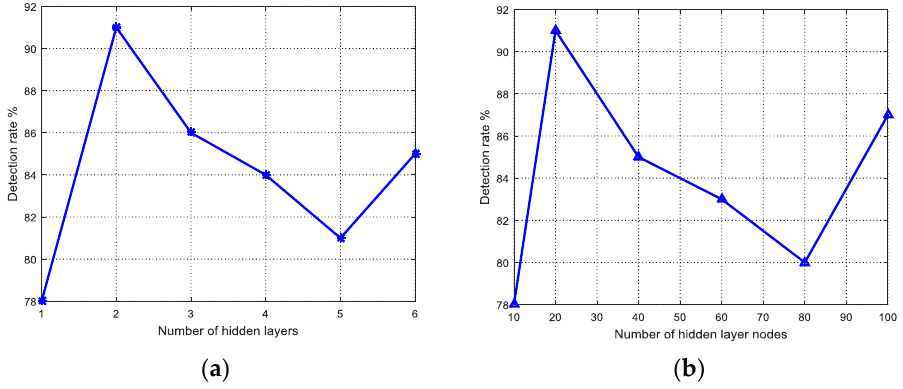
Figure 3. ( a ) The correct detection rate changes with the number of hidden layers (20 nodes); ( b ) The correct detection rate varies with the number of hidden layer nodes (2 hidden layers nodes).